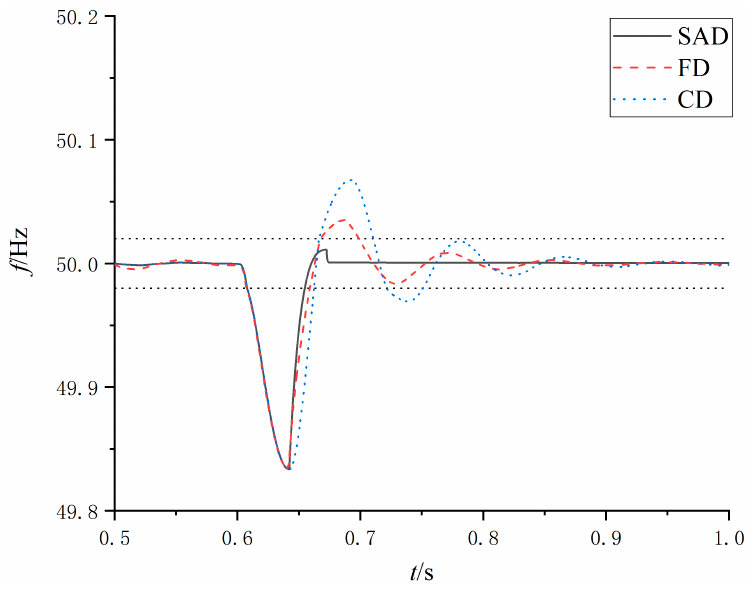
Table 3. Comparison of different control strategies when J is based on frequency change rate.